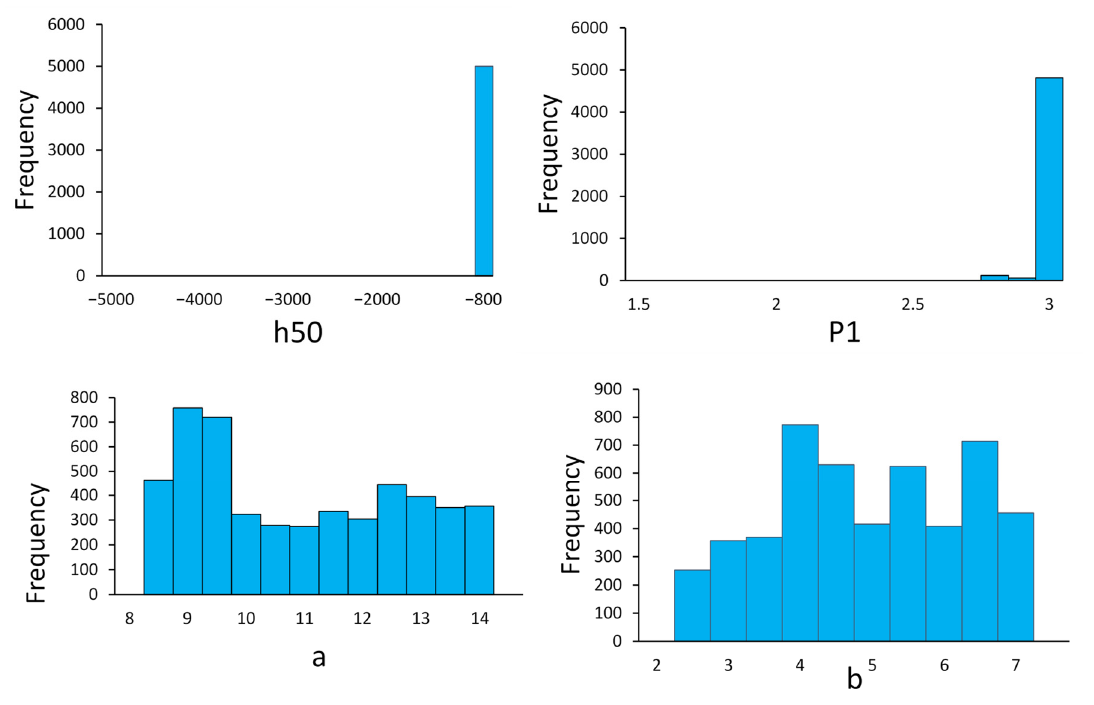
Figure 4. Posterior distributions of root water uptake reduction parameters. The h 50 , P1, a, and b are the water pressure head for a 50% reduction in root water uptake, empirical parameter, threshold, and slope of root water uptake reduction function for salinity stress, respectively. The x -axises of the plots are fixed to prior distribution (range) of the parameters. Table 7. Quantiles of the posterior distribution of the model parameters.